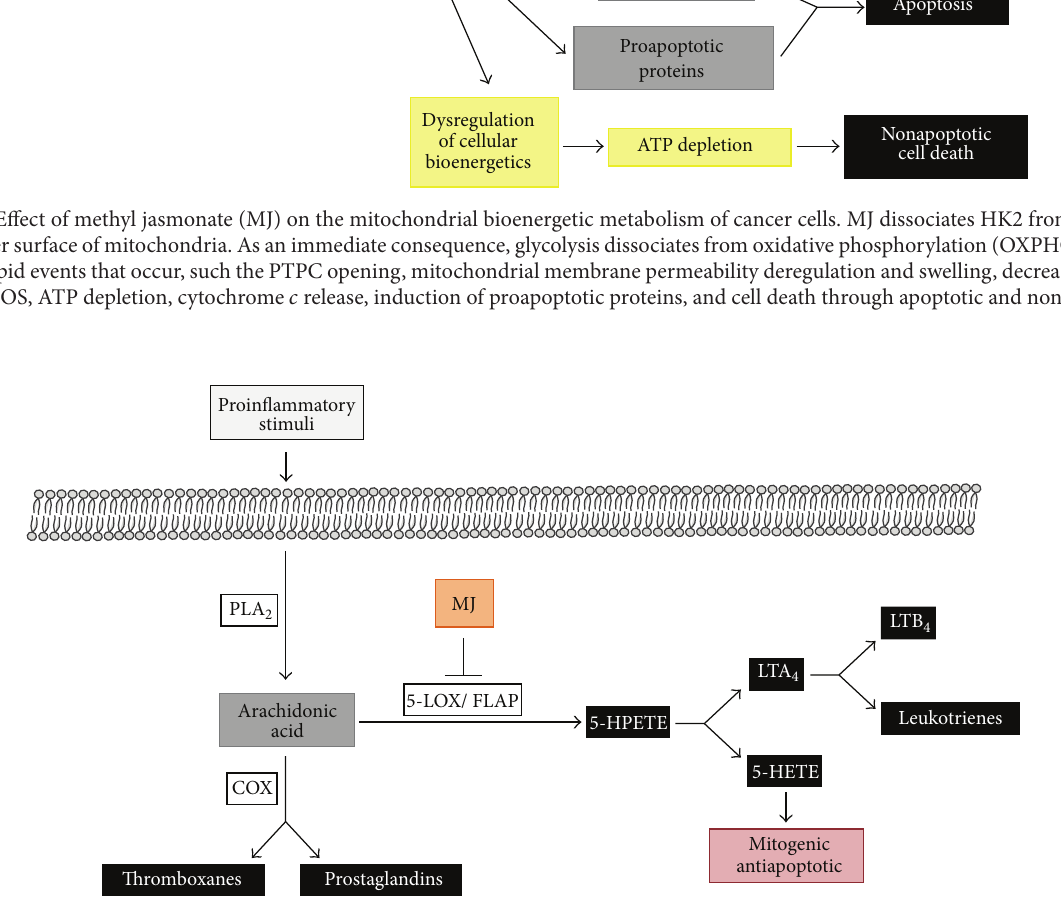
Figure 3: 5-Lipoxygenase (5-LOX) pathway in mammalian cells. Methyl jasmonate (MJ) can inhibit this pathway at the 5-LOX level in cancer